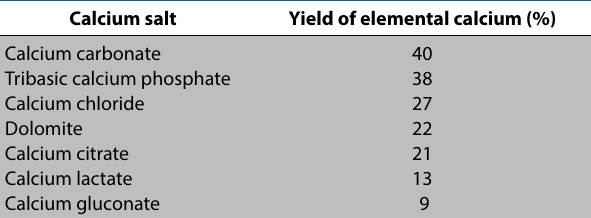
Table X: Elemental calcium content of commonly used calcium